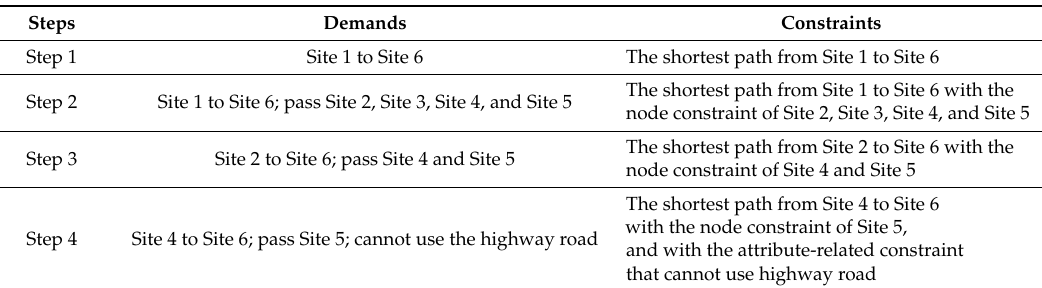
Table 1. Table of constraints in the case